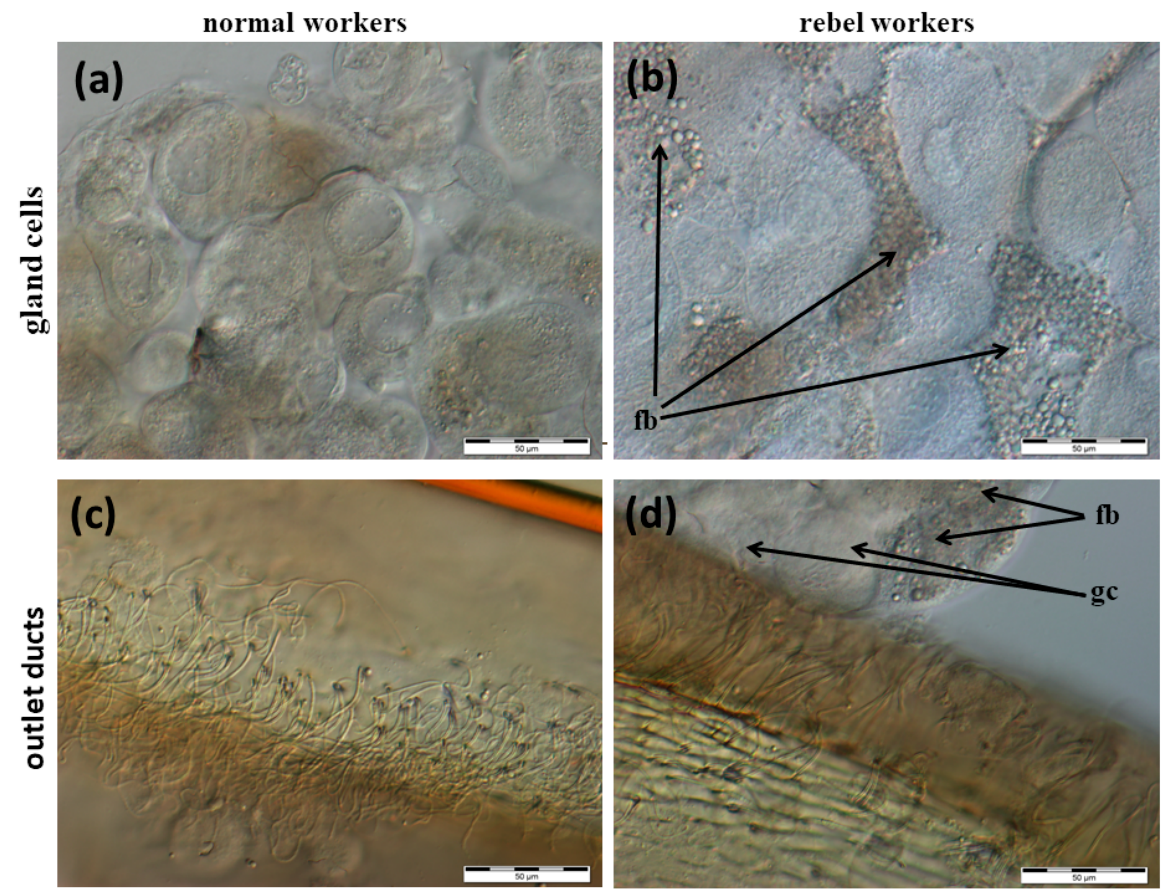
Figure 2. Nasonov glands in normal workers and rebels. ( a ) Gland cells in normal workers; ( b ) gland cells in rebels; ( c ) outlet ducts in normal workers; ( d ) outlet ducts in rebels. fb—fat body cells; gc—gland cells.